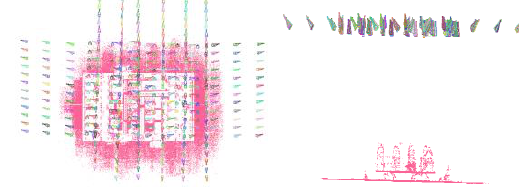
Figure. 9 Visualization of SfM results by using